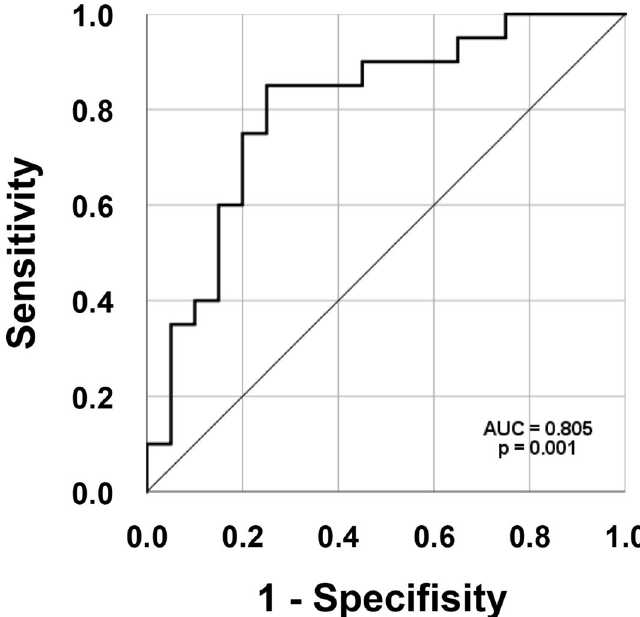
Figure 7. Receiver operating characteristic (ROC) curve showing the prediction of differentially diagnosing intestinal BD from CD using serum MGAM protein expression detected using